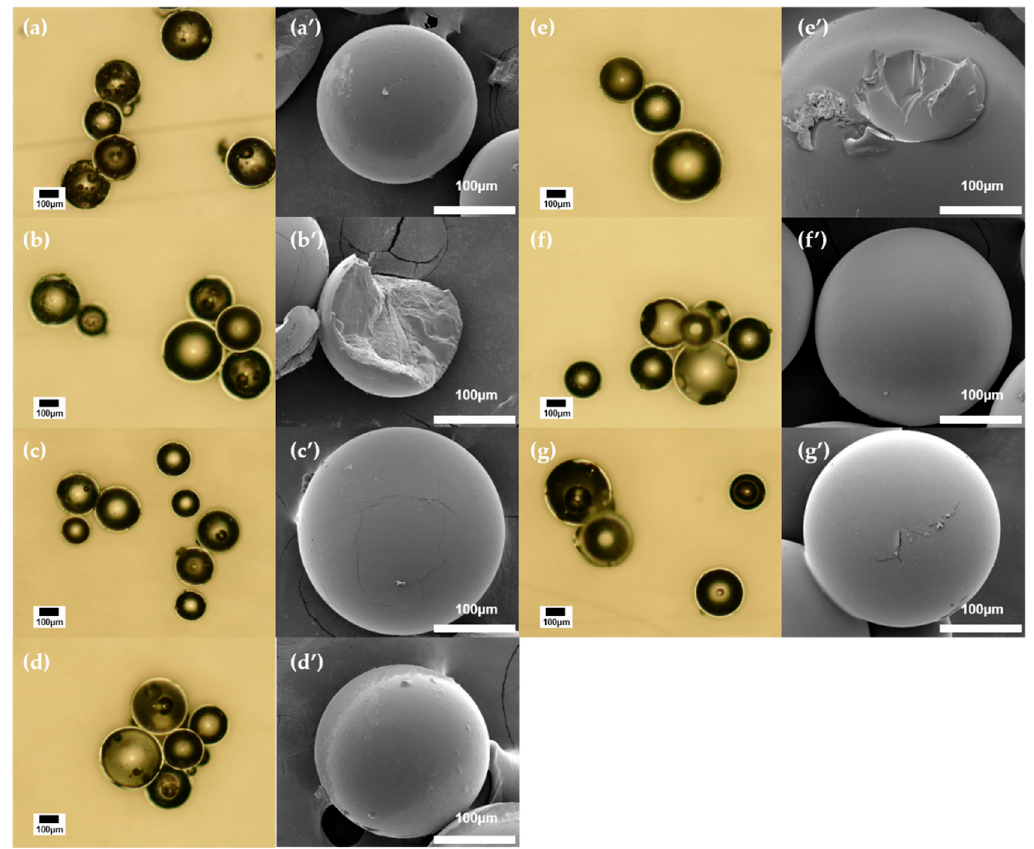
Figure 1. Optical microscopy (OM) images of hyperbranched poly(amidoamine) particles obtained with the following monomer feed ratio; AEP x /MBA 1.5 /span60 1 . (a) x = 0.8, (b) x = 0.9, (c) x = 1.0, (d) x =